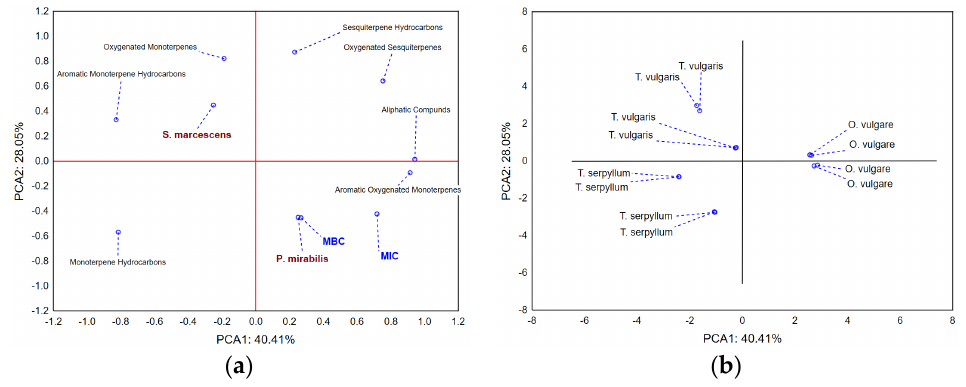
Figure 4. Antimicrobial potential and chemical profiles of the essential oils—classes of compounds. PCA loadings ( a ) and positions of the evaluated samples in the space defined by the first two principal components’ axes ( b ).